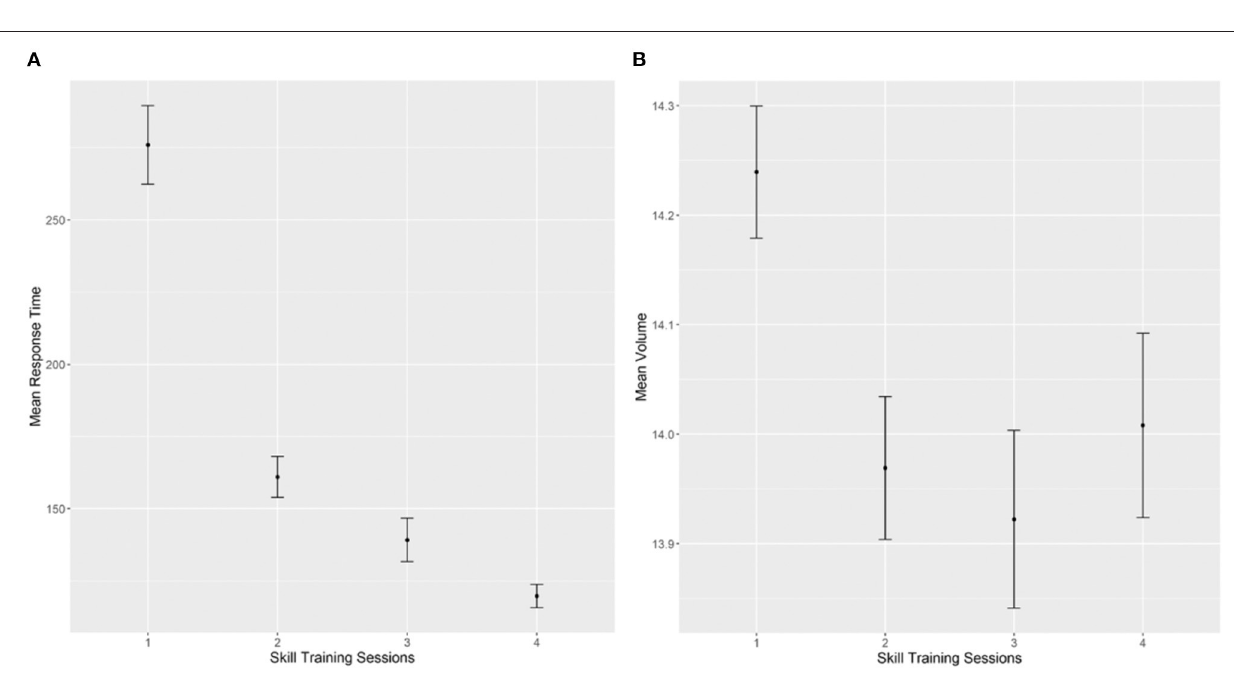
skill training. These results were further confirmed by findings from a second regression in which predictors were entered in the reversed order. When stereoacuity ( LogArcSecs ) was entered as a predictor at the first step, it did not significantly account for laparoscopic performance gains in RT, F (1,16) = 0.02, p = 0.86 (only 0.2% of variance explained). However, adding slope